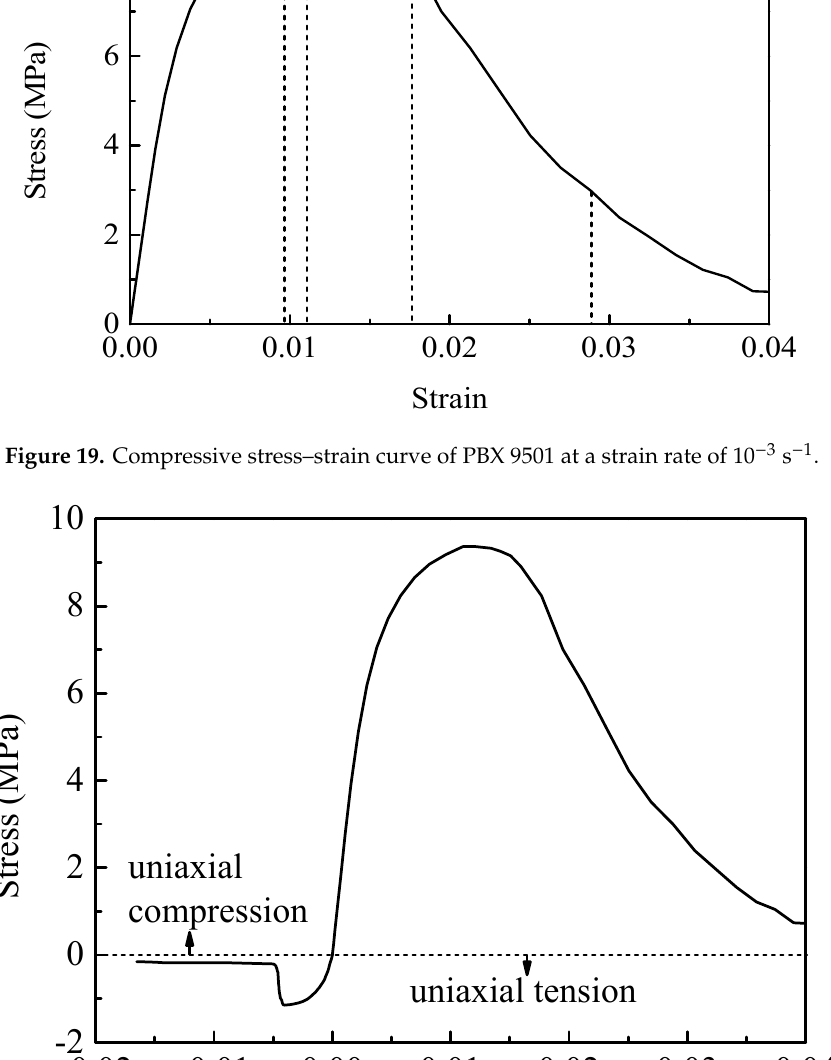
Figure 20. Stress–strain curve of PBX 9501 at a strain rate of 10 − 3 s − 1 .